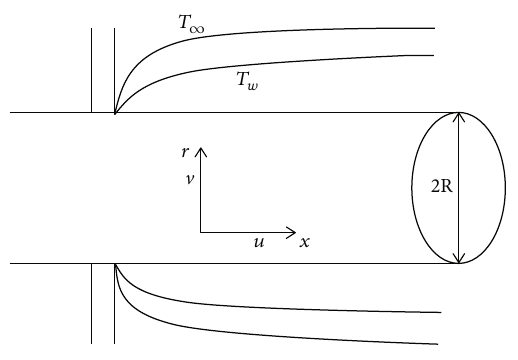
Figure 1: Physical model of the